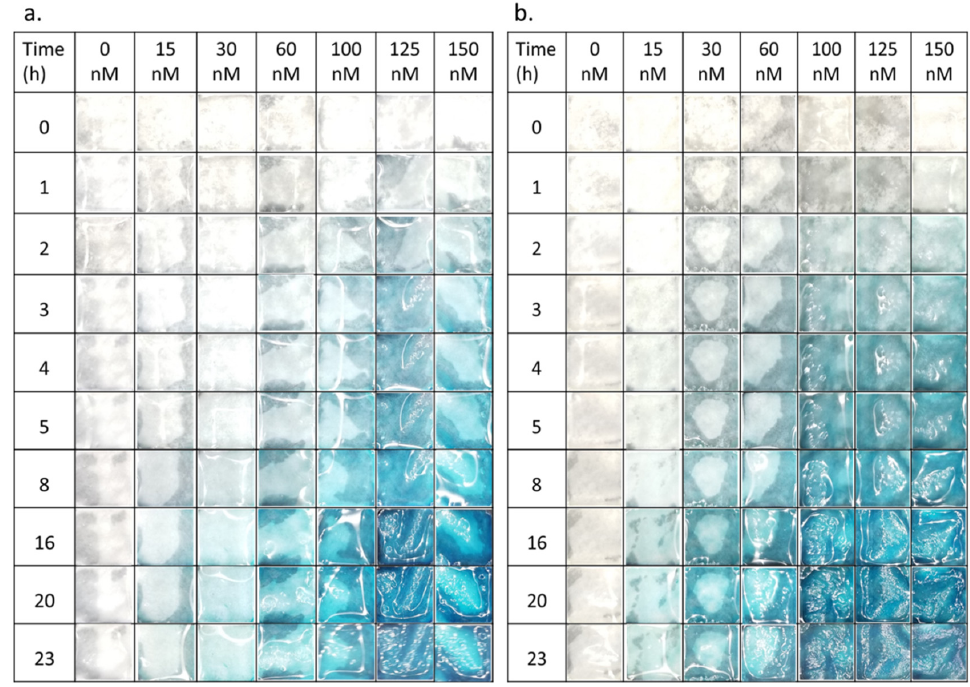
Figure 3. Photographs of visible color change of chitosan-g-X-Gluc coated paper after incubation in different ß-Gus concentrations ( a ) in phosphate-buffered saline (PBS) and ( b ) in lysogeny broth (LB).